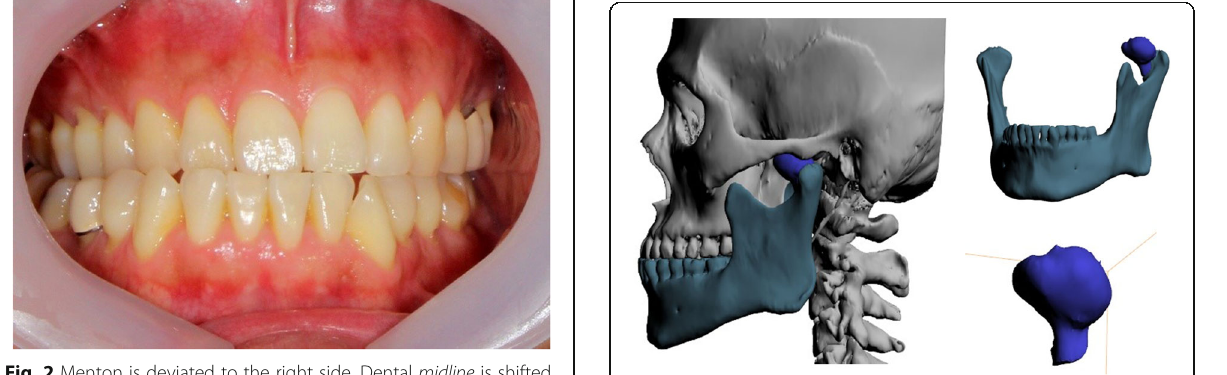
Fig. 2 Menton is deviated to the right side. Dental midline is shifted to the right side